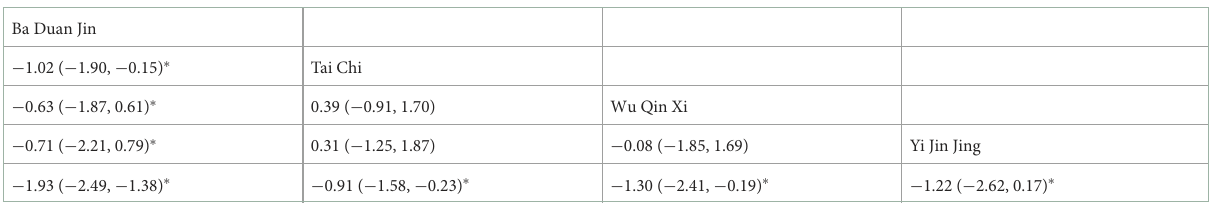
TABLE 1 Results of the network meta-analysis (SMD vs. 95% CI) of the effects of different traditional exercises on TUGT in the elderly. Ba Duan